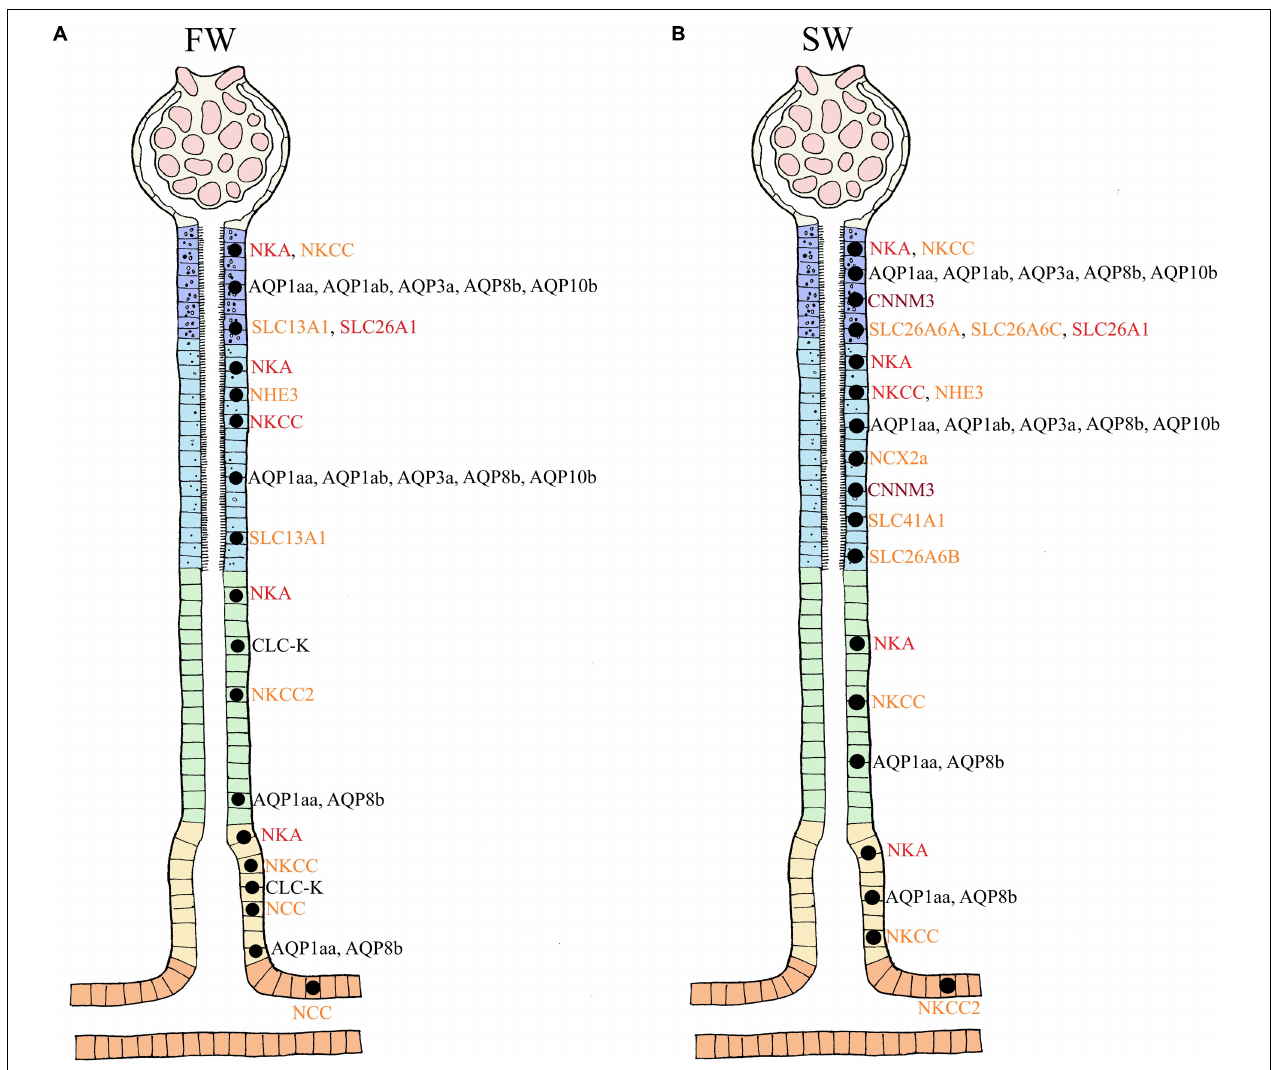
FIGURE 8 | Overview summary of localization of the transporters involved in ion and water transport in euryhaline FW (A) and SW (B) teleosts. Based on the current molecular analysis in teleosts, locations in the nephron are presented in FW and SW environments. For the following transporters, the experimental analysis has not distinguished between proximal tubule I and II; AQP1aa, AQP1ab, AQP3a, AQP8b, AQP10b, SLC13A1. The NKCC in proximal tubule I/II and distal/collecting duct are based on the detection of a general NKCC antibody which do not distinguish between NKCC1 and NKCC2. The NKCC2 was later detected only in the distal tubule of FW fish and not in the proximal tubule I or II. The NKCC1 may therefore be present in proximal tubules, but specific antibodies still need to verify this. The remaining transporters have been located specifically to the segments presented here in FW (A) and SW (B) conditions. So far, only NCC (FW) and NKCC2 (SW) have been located in the collecting duct, but likely have a reabsorbtive function (Na + , Cl - , water) similar to that observed in the collecting tubule. Apical (orange), basolateral (dark red), and multiple locations